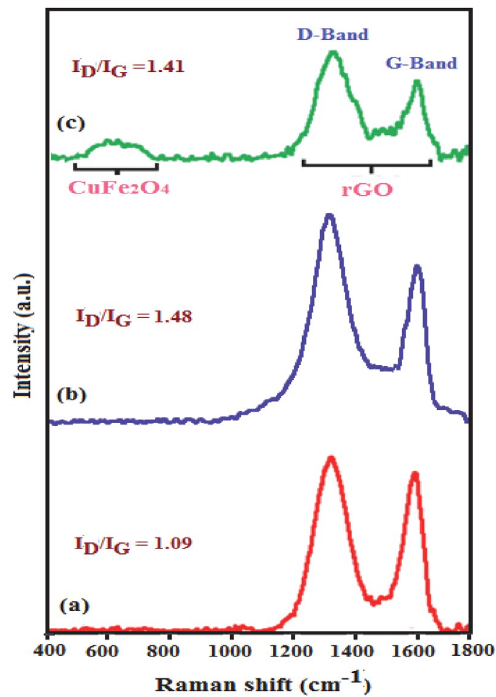
Figure 6. Raman spectra of (a) GO, (b) rGO and (c) Ag/CuFe 2 O 4 /